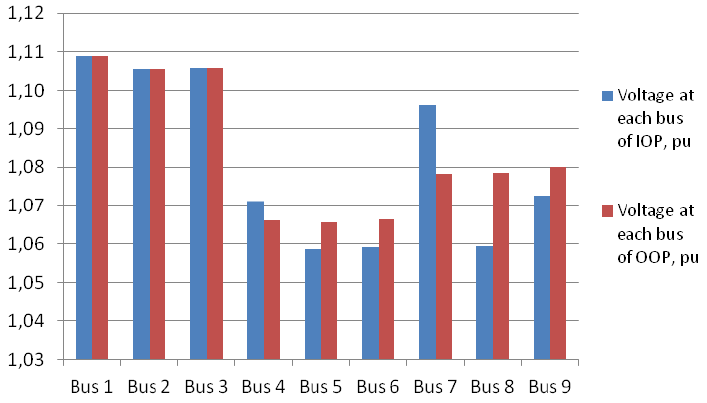
Figure 9. Voltage improvement at each